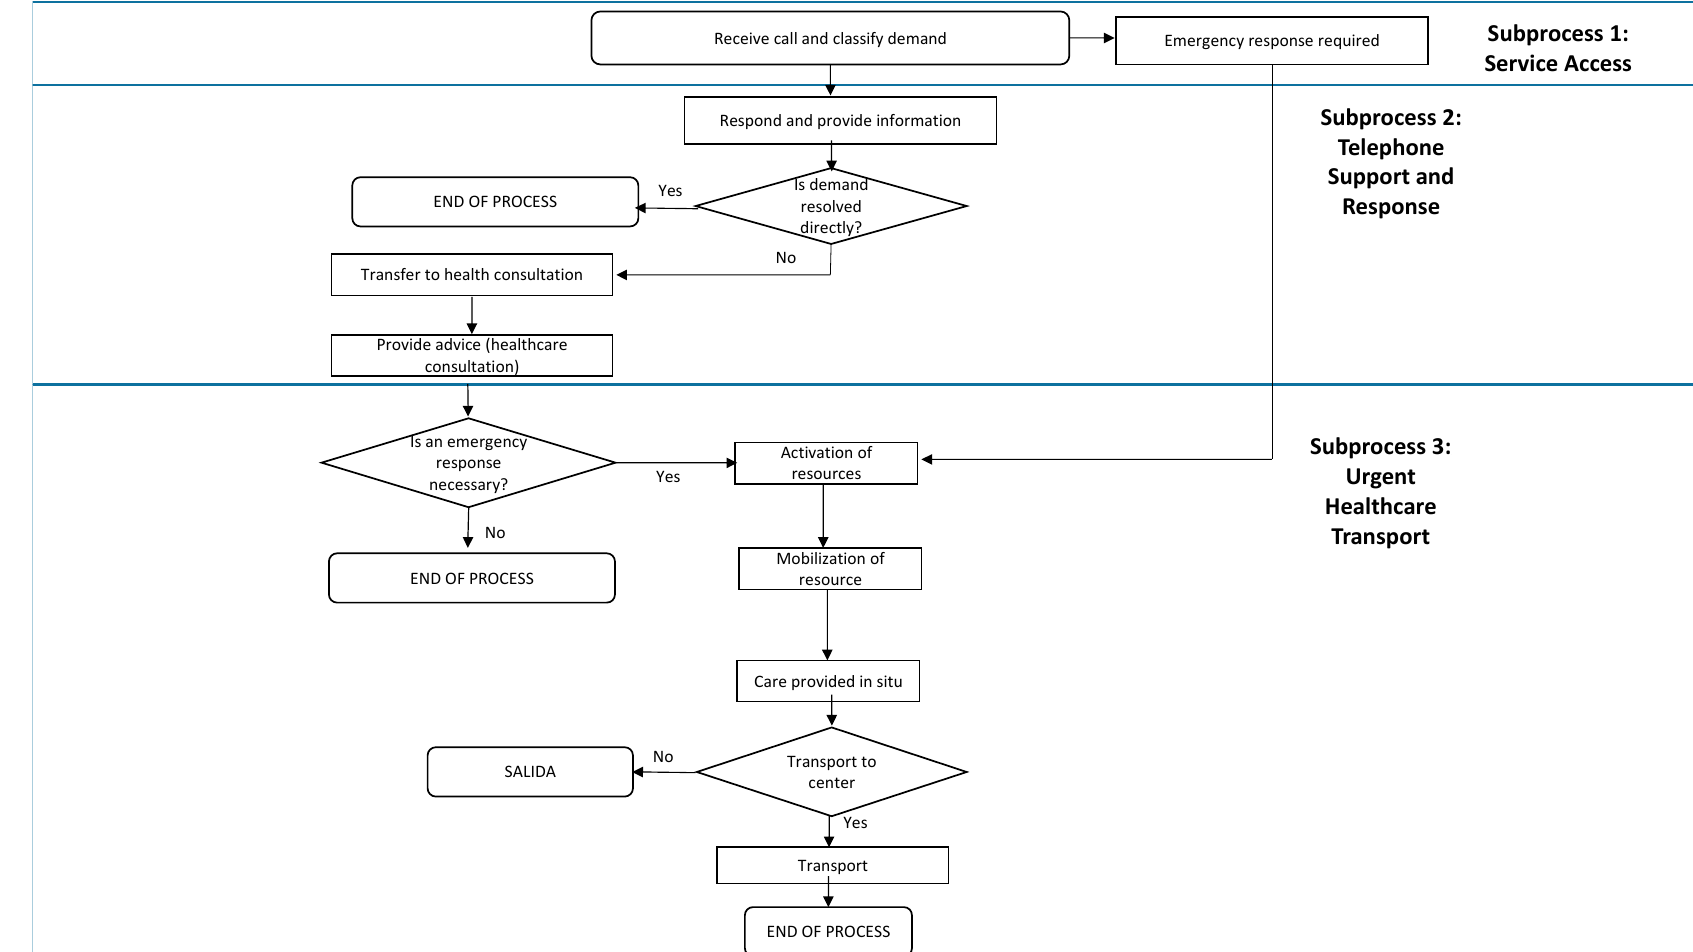
Figure 1. SEM ‐ 061 care process. Figure 1. SEM-061 care